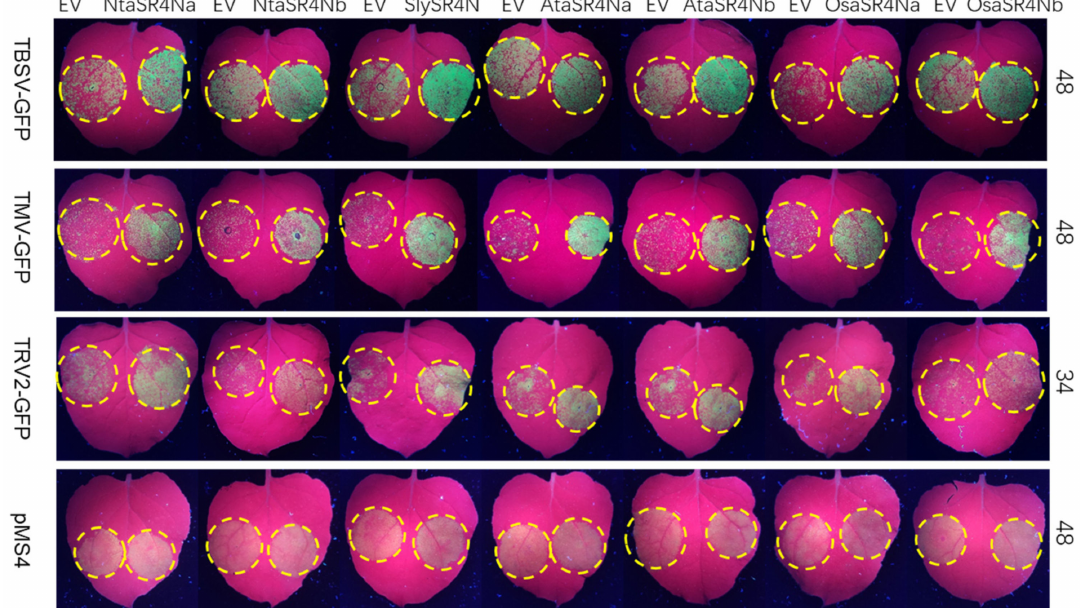
Figure 7. SR4N promotes the replication of multiple viruses but not the expression of the transgene. Yellow dashed circles mark the infiltrated patches. The viruses indicated to the left of each row and EV or SR4N indicated on top of each leaf were co-infiltrated. Images were taken at timepoint HPI are indicated to the right of each row. TBSV-GFP agrobacterium was infiltrated at a final OD600 of 0.02, TMV-GFP at 0.5, TRV1 and TRV2-GFP at 0.01, pMS4 at 0.05, and EV and SR4N agrobacteria at